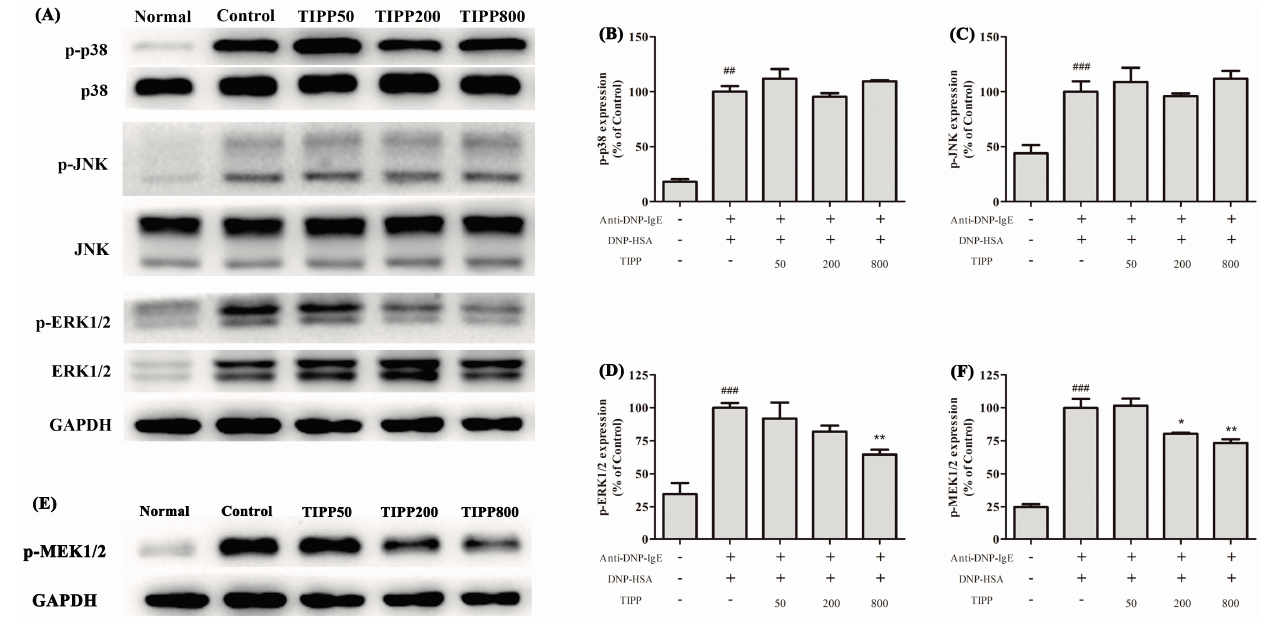
Figure 8. Effects of TIPP on the activation of mitogen-activated protein (MAP) kinases ( A – D ) and extracellular signal-regulated protein kinase (ERK) kinase 1/2 (MEK1/2) ( E , F ) in IgE-antigen complex stimulated RBL-2H3 cells. The Western blot diagram is a representative of three independent experiment diagrams with similar results. Each lane was loaded with 20 μ g of total protein. Results are expressed as mean ± SEM ( n = 3). Compared with Normal group, ## p < 0.01, ### p < 0.001; compared with Control group, * p < 0.05, ** p <